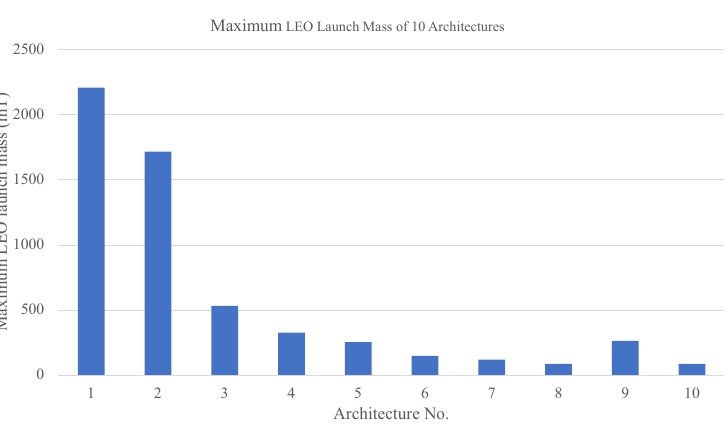
Figure 18. Maximum LEO launch mass of 10 different